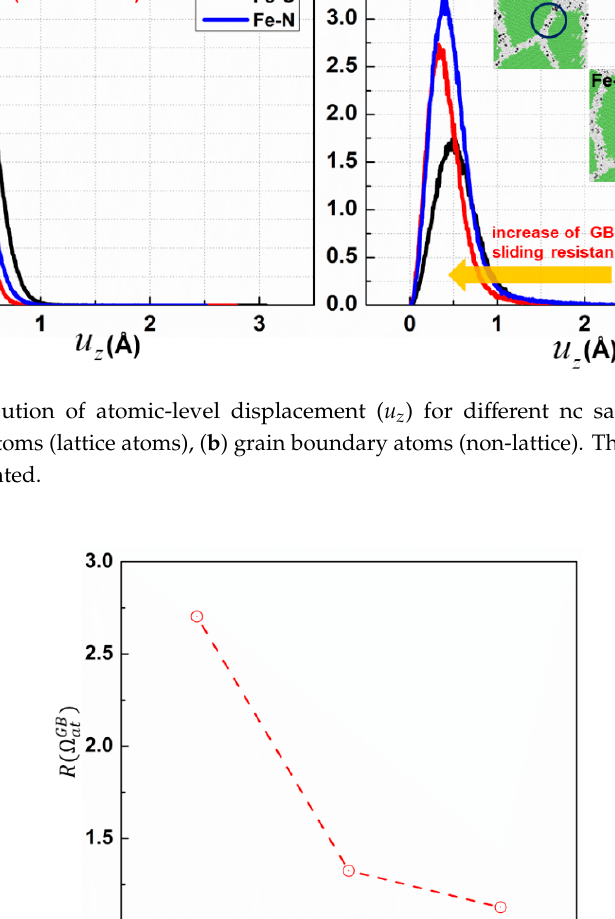
R Ω , between the number of GB atoms with ) , between the number of GB atoms with Ω GB at at < Ω Fe Ω < Ω GB , corresponding to di ff erent nc corresponding to different nc samples. at at ,0 ,0 at ,